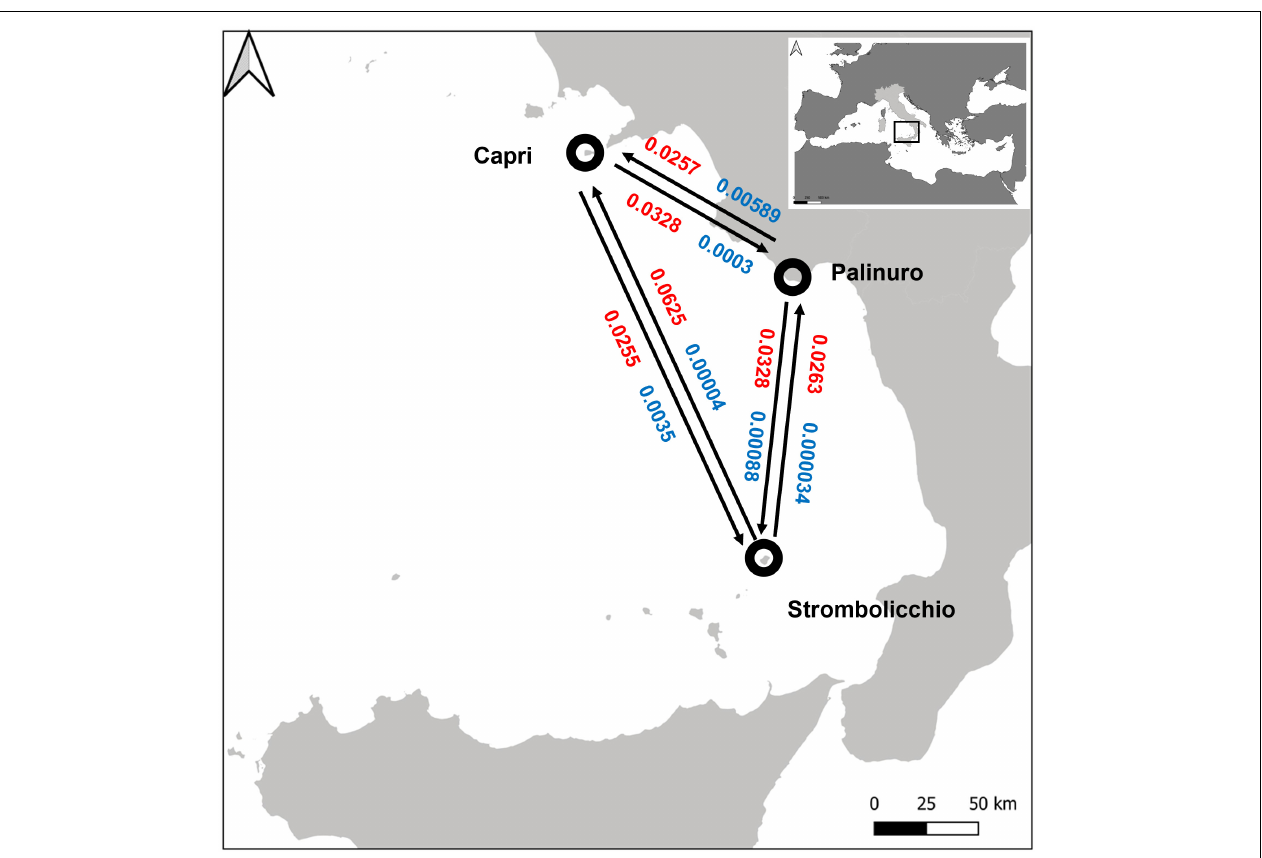
FIGURE 6 | Estimates of the mean posterior recent (blue) and historical (red) migration rate among 25 individuals (SNPs present in at least 95% individuals). The circles represent populations and arrows indicate the direction of migrant individuals between different populations. The inset plot at the top right of the figure reports the position of the map in the Mediterranean